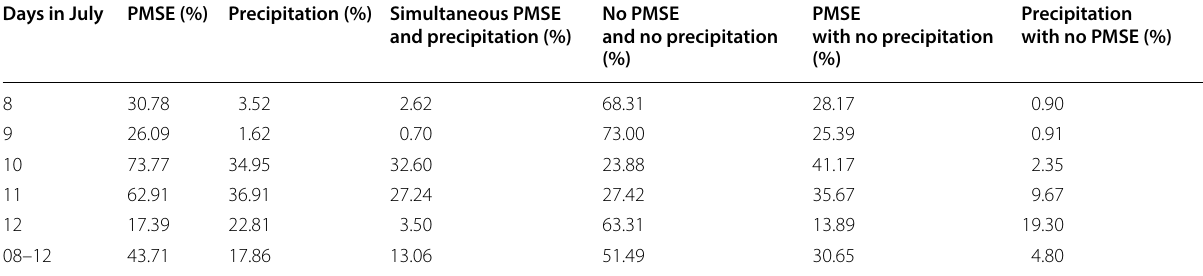
Table 2 Details about PMSE and particle precipitation during 5-day campaign Days in July PMSE (%) Precipitation (%) Simultaneous PMSE